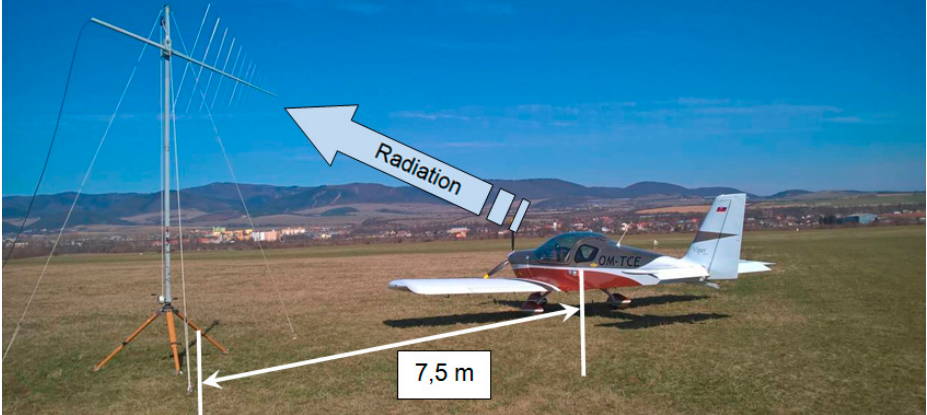
Figure 9. Measurement at a large position angle of θ = 30° at a distance of 7.5 m.